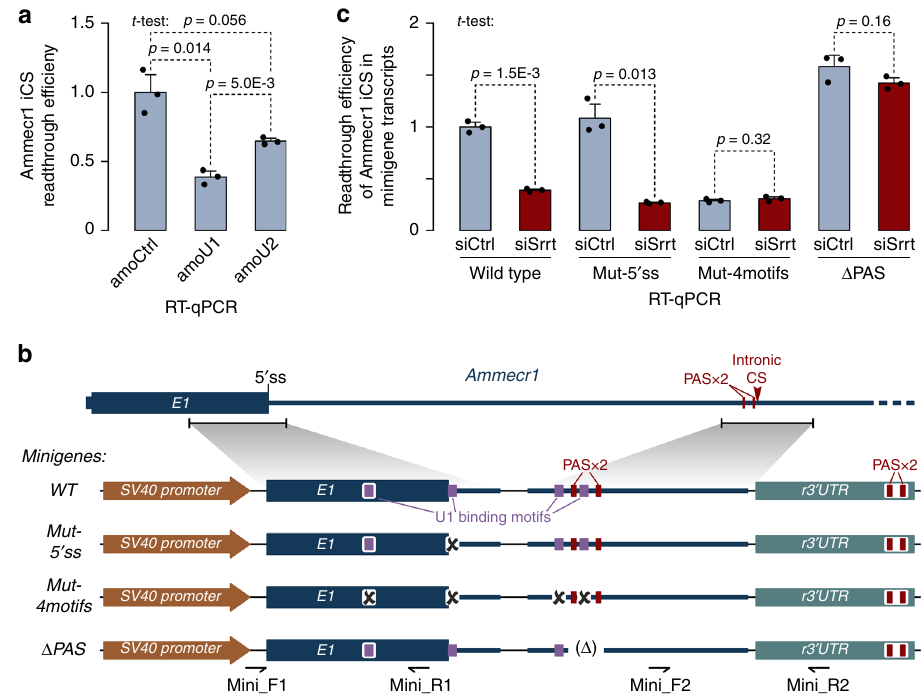
Fig. 6 Srrt-mediated readthrough of Ammecr1 iCS depends on telescripting. a Mouse ESCs were nucleofected with a control morpholino oligonucleotide (amoCtrl) or antisense morpholinos targeting either U1 or U2 snRNA (amoU1 and amoU2) for 8 h and the effect of these treatments on the iCS readthrough was analyzed using RT-qPCR. Note that amoU1 leads to a robust decrease in the CS readthrough ef fi ciency compared to amoCtrl and amoU2. b Ammecr1-based minigene constructs used in telescripting assays in c . PSV40 , SV40 enhancer, and early promoter; E1 , the fi rst exon of Ammecr1 gene; r3 ′ UTR , recombinant 3 ′ UTR from SV40 virus. c ESCs transiently transfected with wild type ( WT ) or mutant ( Mut-5 ′ ss , Mut-4motifs , or Δ PAS ) minigenes from b were treated with either siCtrl or siSrrt and the Ammecr1 intronic CS ef fi ciency was assayed as a ratio between downstream [mini_F2/mini_R2 primers in b ] and upstream RT-qPCR signals [mini_F1/mini_R1 primers in b ]. Note that Srrt stimulates CS readthrough in the WT minigene, similar to its effect on the endogenously encoded Ammecr1 . Mutation of a single U1-binding motif corresponding to the 5 ′ ss at the beginning of the fi rst intron ( Mut-5 ′ ss ) does not alter the minigene response to Srrt knockdown; however, mutation of 5 ′ ss and three additional sites potentially interacting with U1 ( Mut-4motifs ) results in a constitutive cleavage/polyadenylation phenotype. Conversely, deletion of the two PAS motifs ( Δ PAS ) leads to constitutive readthrough. Data on a and c were averaged from three experiments ± SD and compared by a two-tailed t -test. Readthrough ef fi ciencies in the amoCtrl and WT /siCtrl samples, respectively, were set to 1. Source data are provided as a Source Data fi